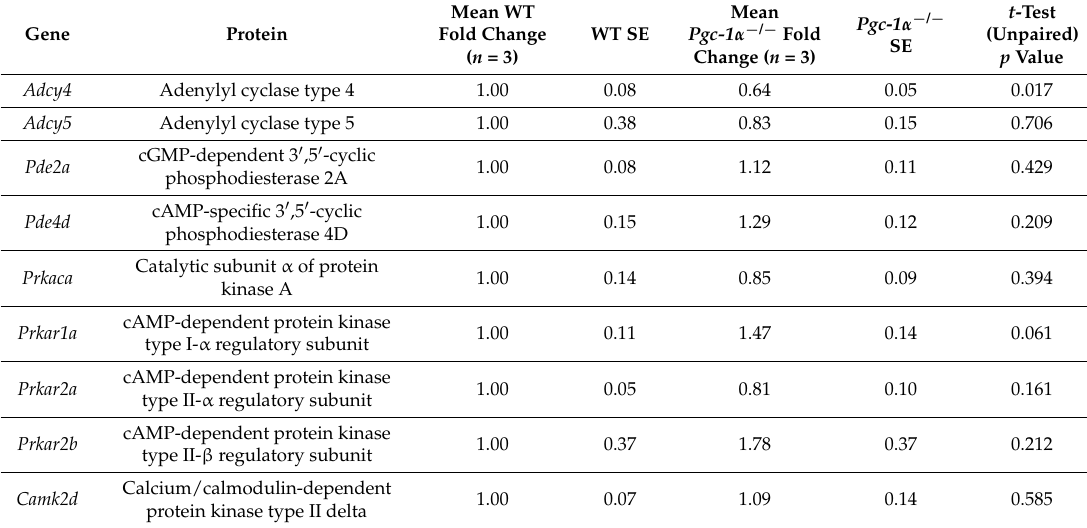
Table 7. The mean gene fold changes underlying the cAMP pathway in Pgc-1 α − / − compared to WT atria.